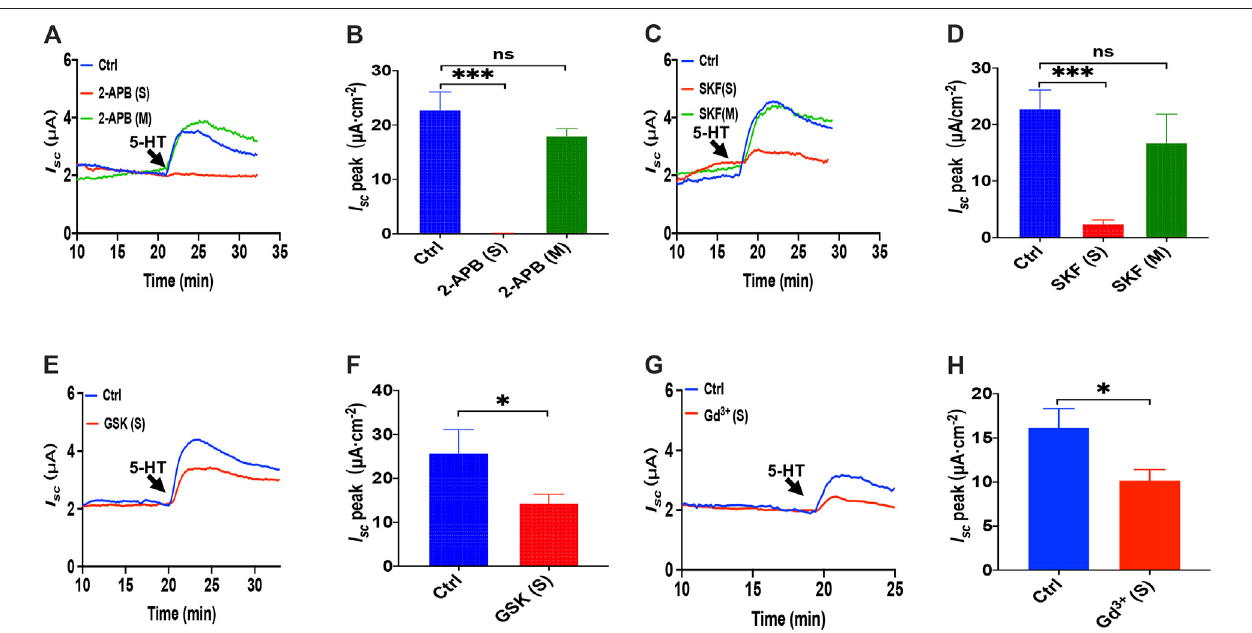
FIGURE 6 | 5-HT induced Ca 2+ -dependent intestinal ion secretion by serosal SOCE mechanism in mice duodenum. (A) Time course of 5-HT-evoked I sc after 2- aminoethoxydiphenylborate (2-APB,100 μ M, n (cid:2) 6) added totheserosalor mucosal side. (B) 5-HT-stimulatedmurineduodenal I sc peak after 2-APB wasadded tothe serosal or mucosal side. (C) Time course of 5-HT-evoked I sc after SKF-96365 (SKF, 30 μ M, n (cid:2) 6) added to the serosal or mucosal side. (D) 5-HT-evoked duodenal I sc peak after SKF-96365 wasadded tothe serosal or mucosal side. (E) Timecourse of5-HT-evoked I sc after GSK-7975A (GSK,100 μ M, n (cid:2) 6) added tothe serosal side. (F) 5-HT-evoked I sc peak after GSK-7975A was added to the serosal side. (G-H) 5-HT-evoked I sc after GdCl 3 (Gd 3+ , 30 μ M, n (cid:2) 6) added to the side. Ctrl represents the control without drug treatment. Results are presented as mean ± SE. NS, no signi fi cant differences, * p < 0.05, *** p < 0.001 vs. corresponding control by Student ’ s unpaired, two-tailed t-test or one-way ANOVA followed Dunnett ’ s post-test.